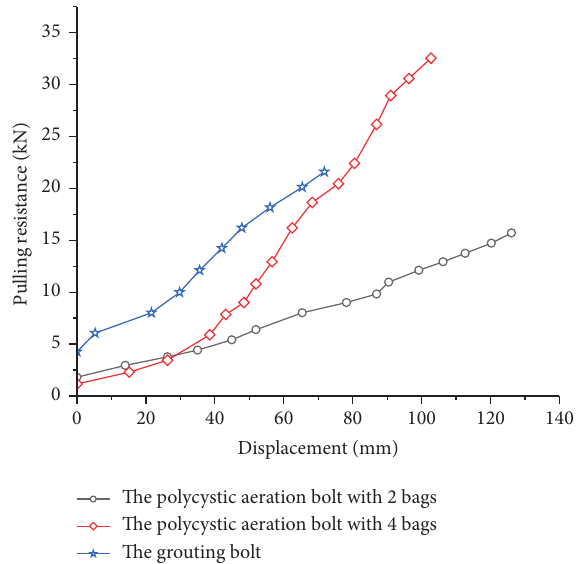
Figure 17: The relationships between pulling resistance and